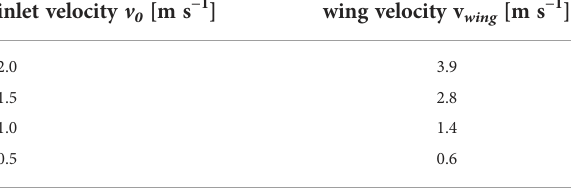
TABLE 1 Resulting wing velocities vwing of the fi nal design from inlet velocities v0. inlet velocity v 0 [m s − 1 ]